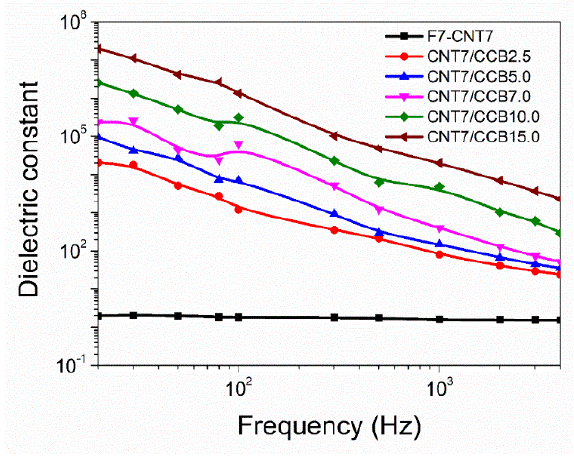
Figure 11. Dielectric constant as a function of frequency of ENR-FeCl 3 filled with CNTs (F7-CNT7) and CNT-CCB hybrid fillers with various CCB loadings at 2.5, 5.0, 7.0, 10.0 and 15.0 phr.